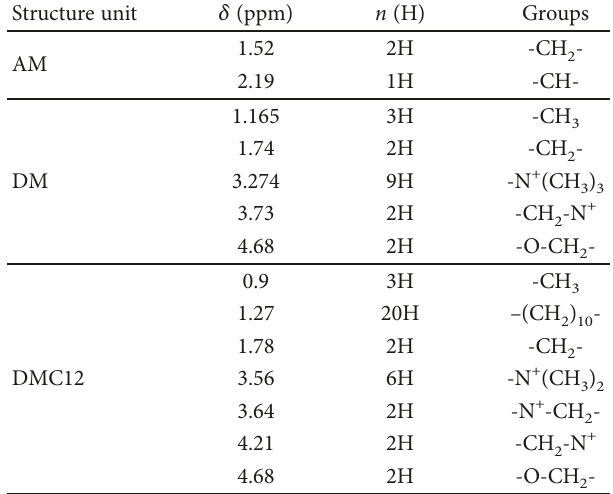
Table 1: 1 H-NMR spectrum analysis of P(AM-DM-DMC12). Structure unit δ (ppm) n (H)